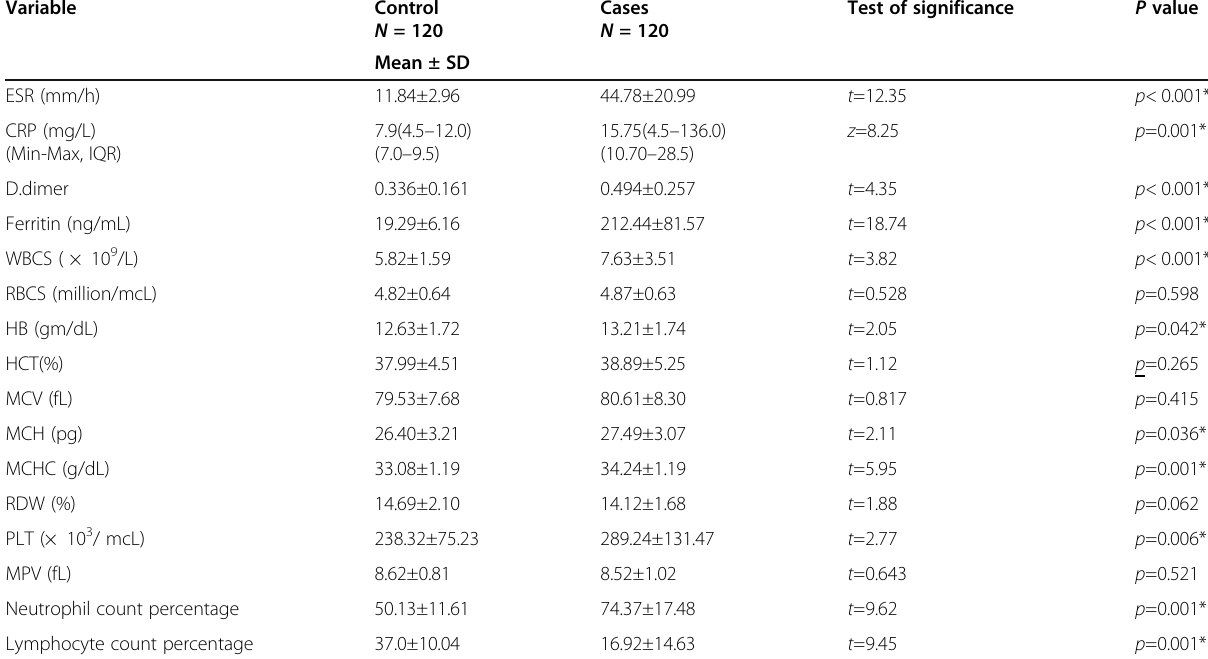
Table 2 Inflammatory and haematological characteristics of participants